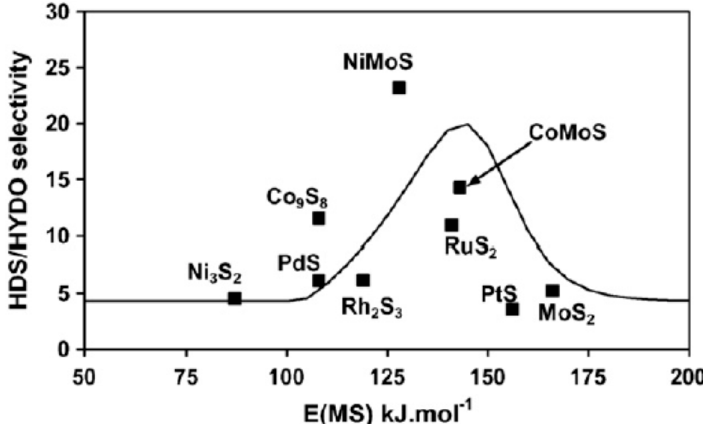
Figure 6. Selectivity hydrodesulfurization, comparison between experimental results and kinetic model (black line) as a function of sulfur–metal bond energies, E(MS) (T = 250 ◦ C, P = 20 bar, H 2 / feed = 360 l / l). Daudin et al.